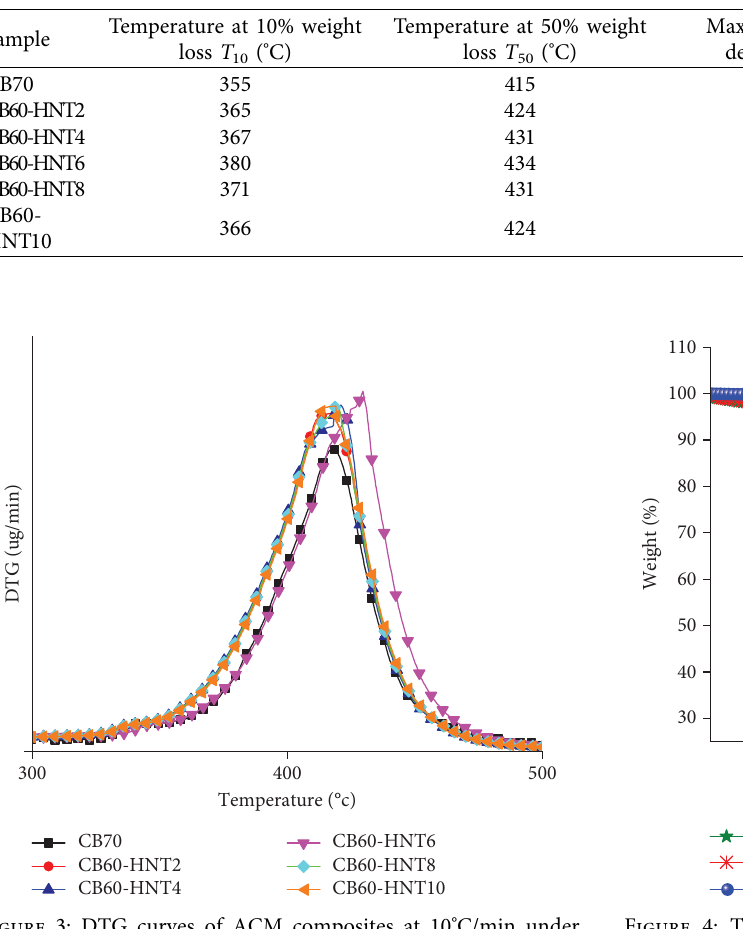
Table 3: TGA characteristics of ACM composites.